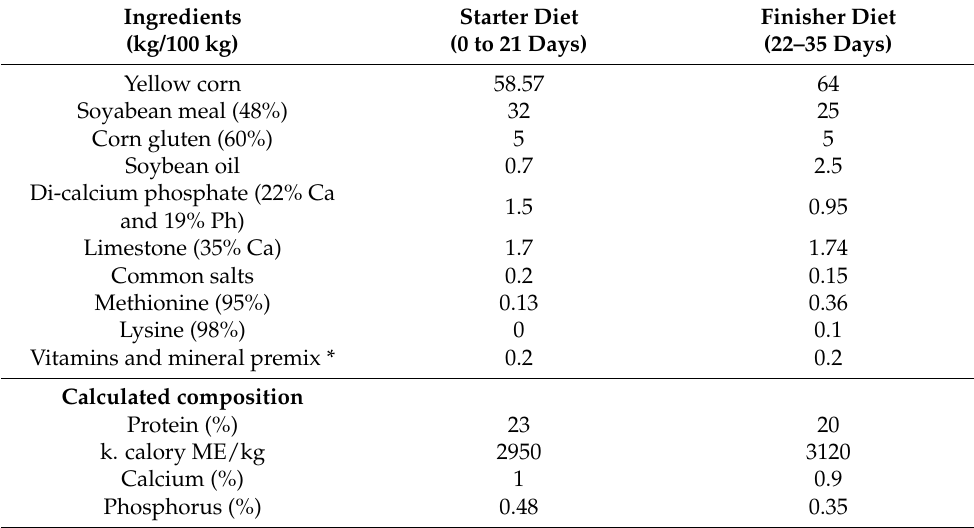
Starter Diet (0 to 21 Days) (22–35 Days)